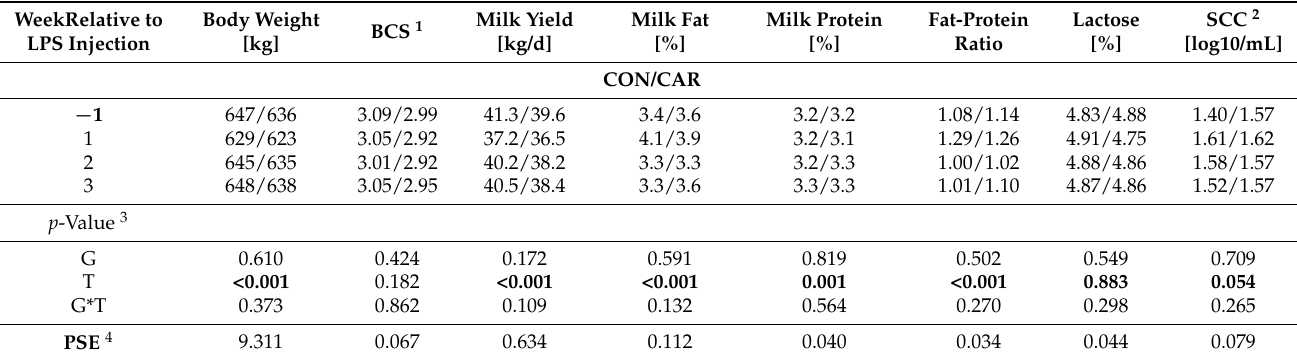
Table A3. Effects of an L -carnitine supplementation on body condition and milk parameters of German Holstein cows challenged by an intravenous injection of lipopolysaccharides (LPS, 0.5 µ g/kg BW) at the first day in week 1.